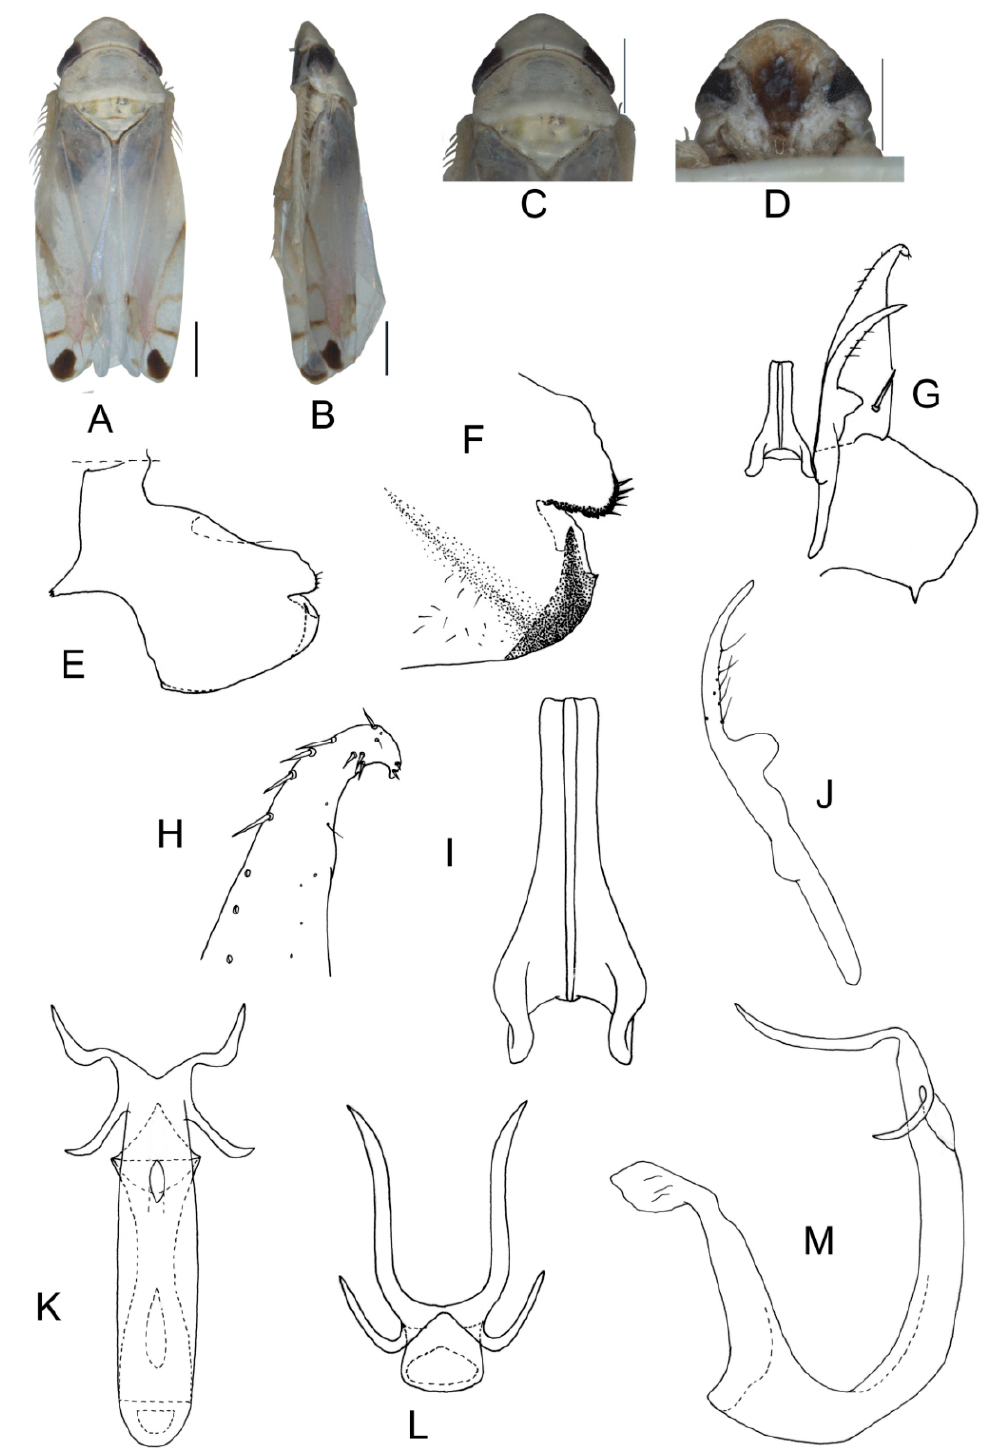
Figure 8. Eurhadina ( Singhardina ) scandens sp. nov. : ( A ) habitus, dorsal view; ( B ) habitus, lateral view; ( C ) head and thorax, dorsal view; ( D ) face; ( E ) male pygofer side, lateral view; ( F ) hind part of pygofer, lateral view; ( G ) subgenital plate, connective, paramere and sternite IX, dorsal view; ( H ) apex of subgenital plate, dorsal view; ( I ) connective, dorsal view; ( J ) paramere, dorsal view; ( K ) aedeagus, posterior view; ( L ) apex of aedeagal shaft, dorsal view; and ( M ) aedeagus, lateral view. Scale bars: 0.5 mm.